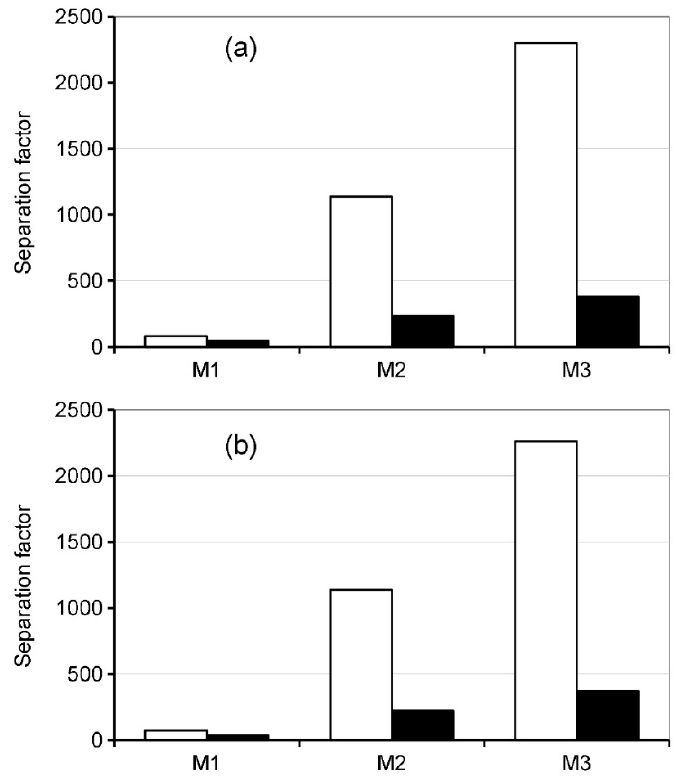
Figure 11. Separation factor of 10 wt % of water in water +isopropanol (white box) and water+ 1,4-dioxane (black box) feed mixtures vs. pristine PVA (M1), PVA/Na + MMT-5(M2) and PVA/Na + MMT-10 (M3) mixed matrix membranes at 30 °C for ( a ) thermally crosslinked membranes and ( b ) glutaraldehyde crosslinked membranes [120].